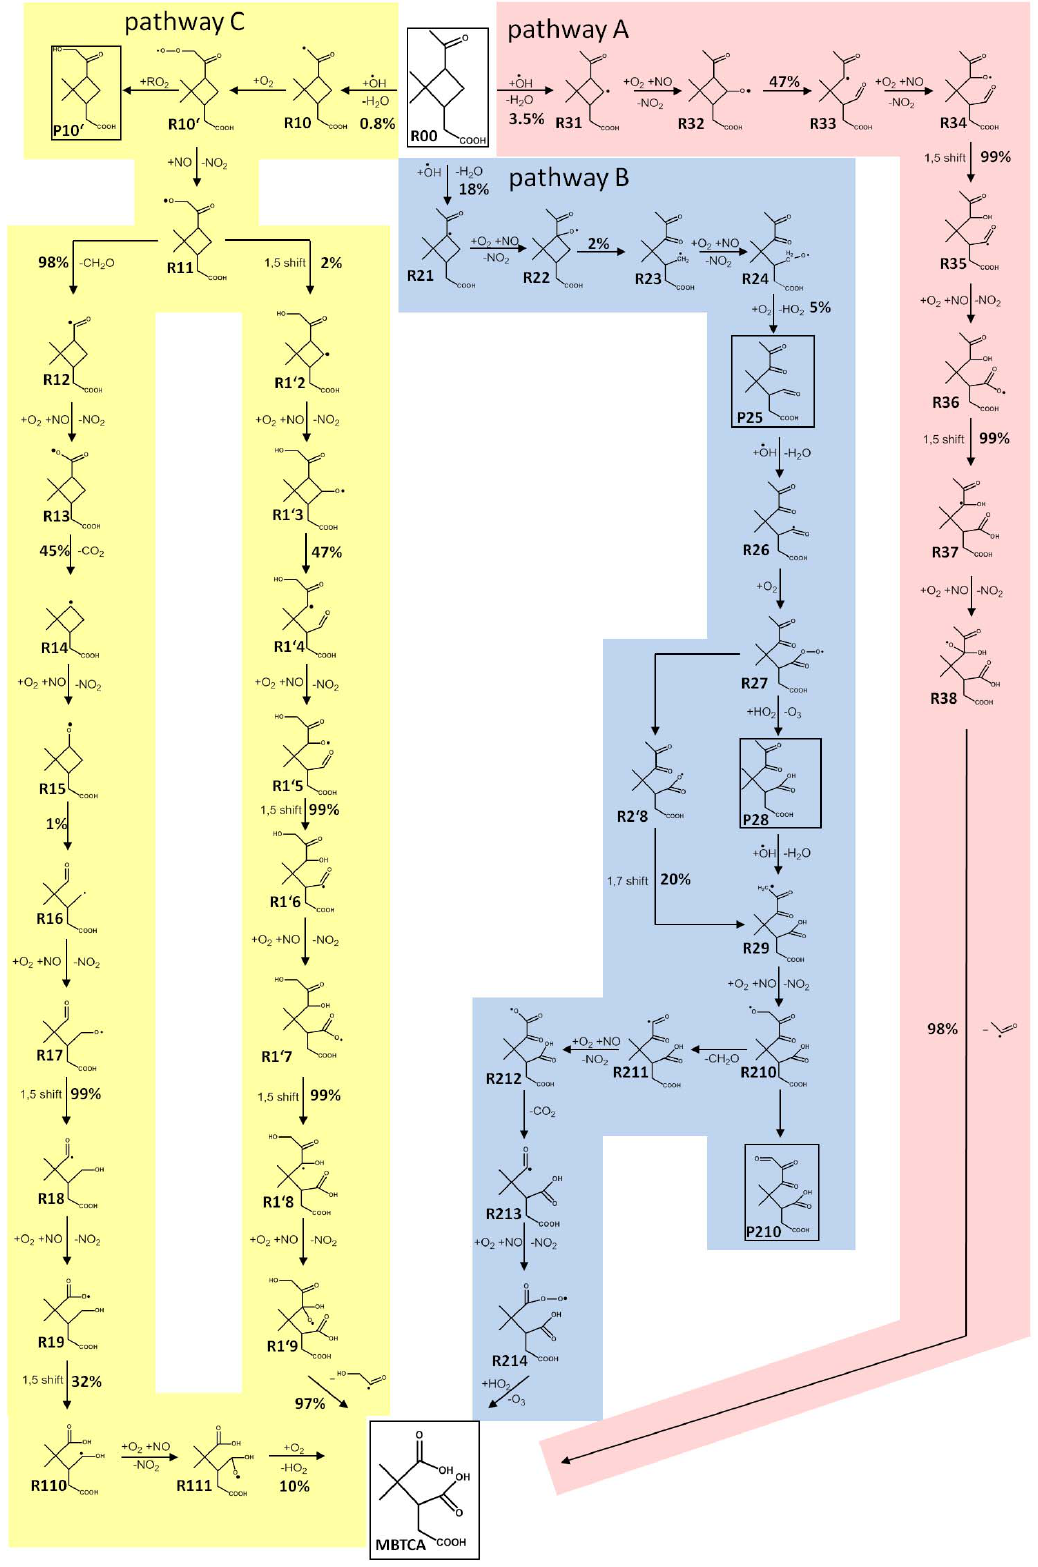
Fig. 6. Proposed formation mechanisms of MBTCA by oxidation of pinonic